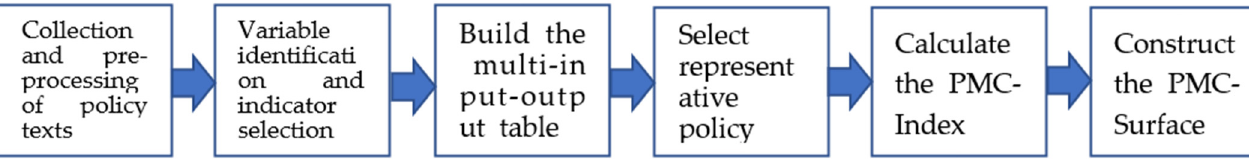
Figure 3. Process of application of PMC-Index and PMC-Surface.